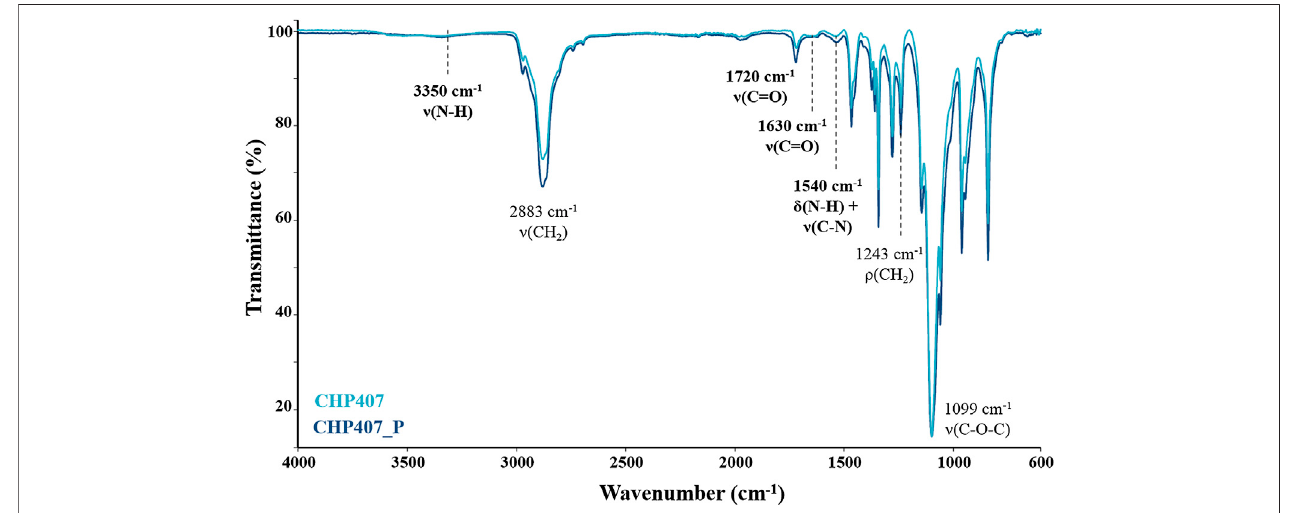
FIGURE1| AverageATR-FTIRspectraofCHP407(lightblue)andCHP407_P(darkblue)polymers.Thebandsprovingthesuccessofthesynthesisarehighlighted in bold.